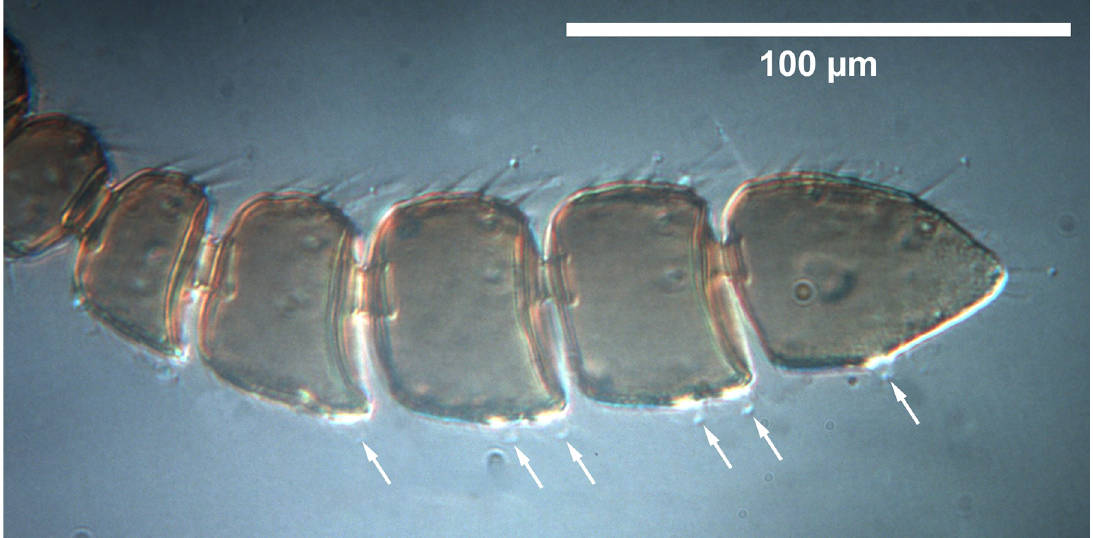
Fig 9. Telenomus nizwaensis Polaszek female paratype. Terminal antennomeres under differential interference contrast. Papillary sensilla indicated by arrows.